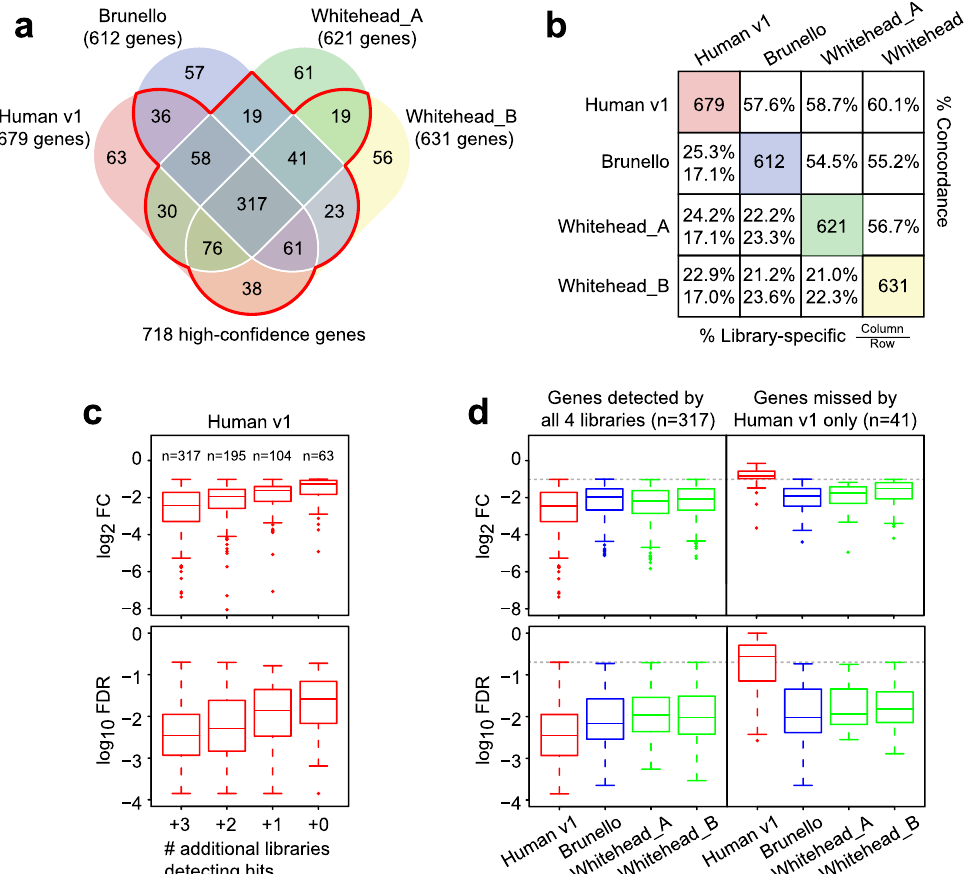
Figure 3. Properties of the depleted genes detected by three second-generation CRISPR libraries. ( a ) Venn diagram showing overlaps of genes detected at FDR ≤ 20% and FC ≤ 0.5. The Whitehead library was separated into two subsets denoted with suffix _A and _B. Genes detected by 2 or more libraries are considered as high- confidence genes. ( b ) Pairwise concordance between libraries of detected depleted genes. ( c ) Box plots showing the FC and FDR of genes detected by the Human v1 library. Genes were grouped by the number of additional libraries which detected those hits. See Supplementary Fig. S1a for the complete result. ( d ) Box plots showing the FC and FDR of genes detected by all 4 libraries and of genes missed only by the Human v1 library. See Supplementary Figure S1b for the complete